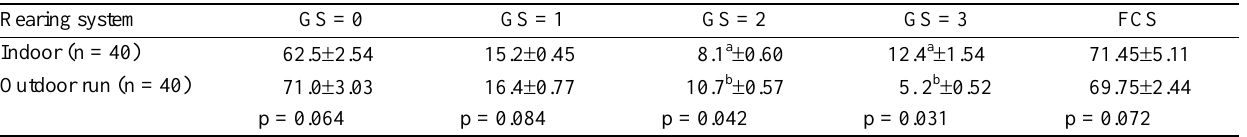
Table 6. Effects of rearing system on Gait Score (GS) Rearing